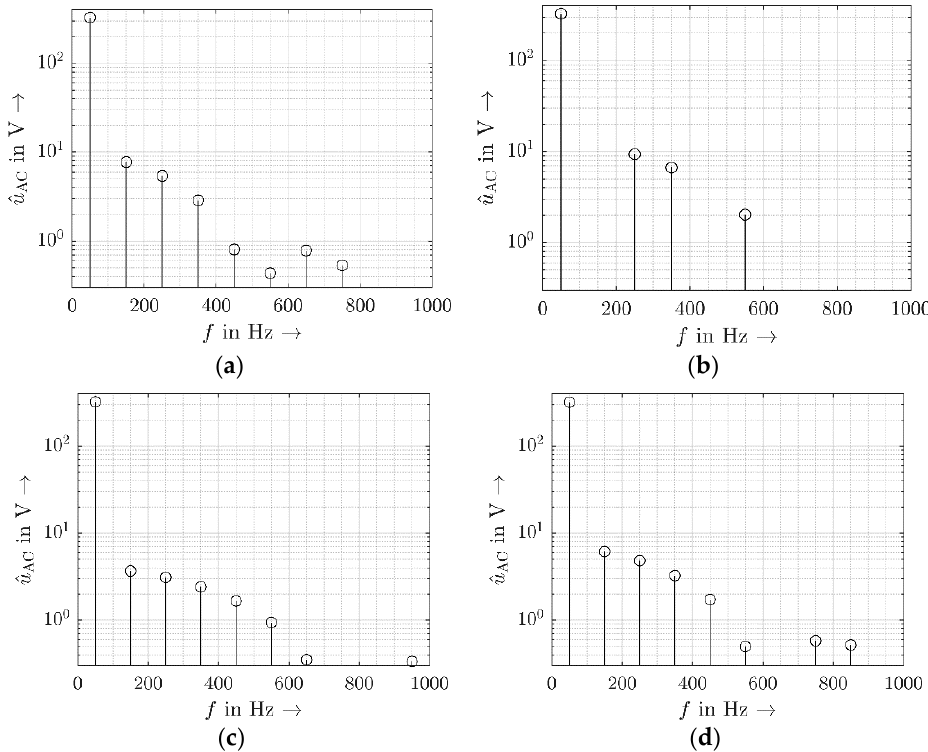
Figure 3. Amplitude spectrum ˆ u AC of validation data set 1 ( a ), validation data set 2 ( b ), validation data set 3 ( c ) and validation data set 4 ( d